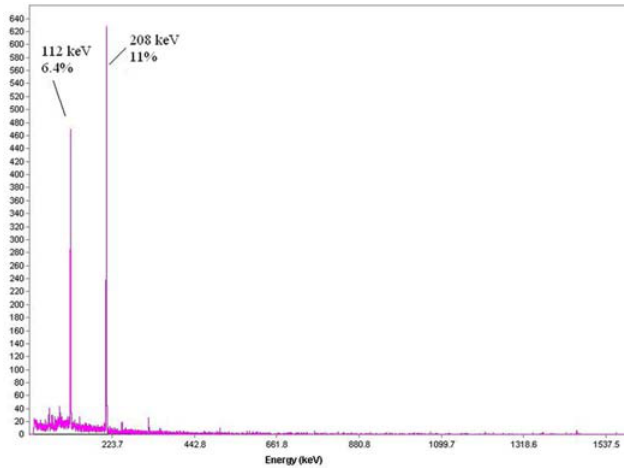
solution used 3